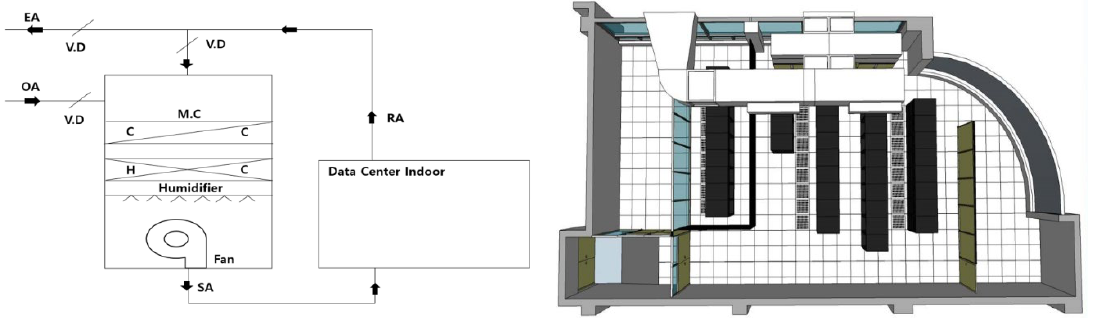
Figure 2. Schematic diagram and Floor plan of the outdoor air-cooling system. Table 2. Comparison of indoor conditions before and after the improvements.